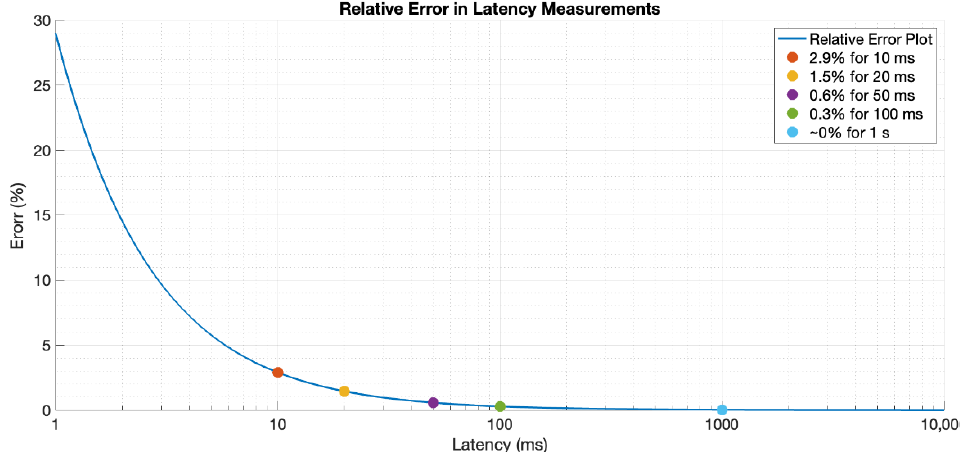
Figure 7. Testbed’s relative error with respect to the latency value.